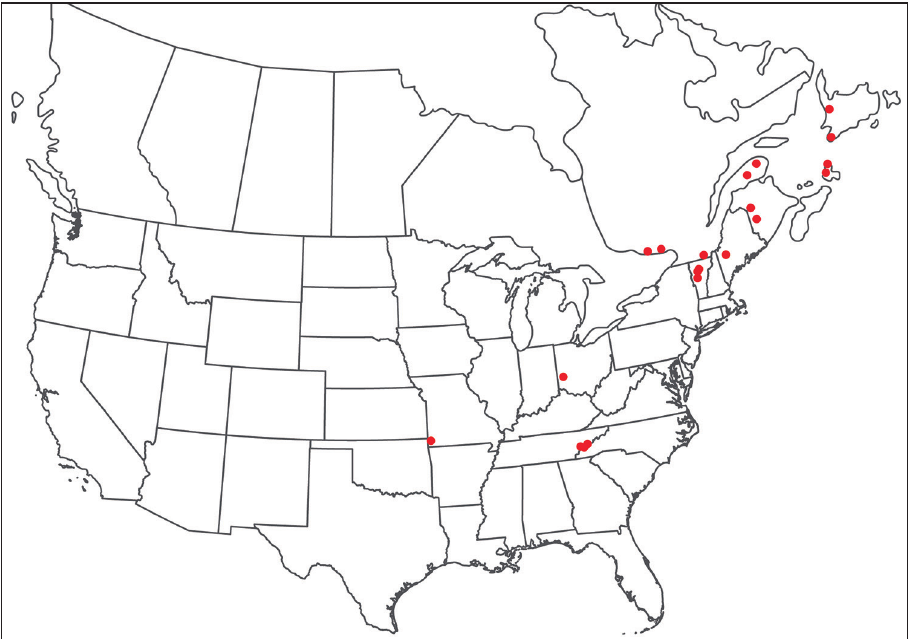
Figure 134. Torrenticola magnexa